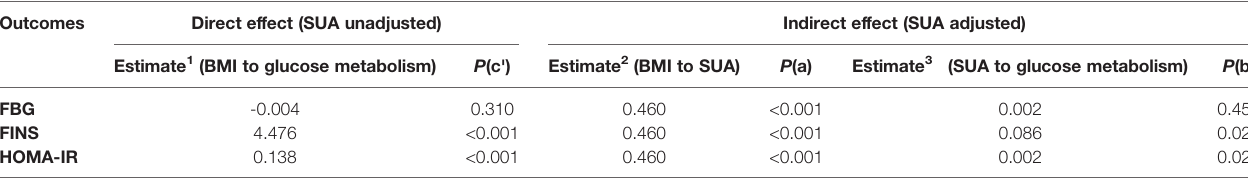
TABLE 5 | Direct and indirect effects of BMI on markers of glucose metabolism with SUA as a mediator.